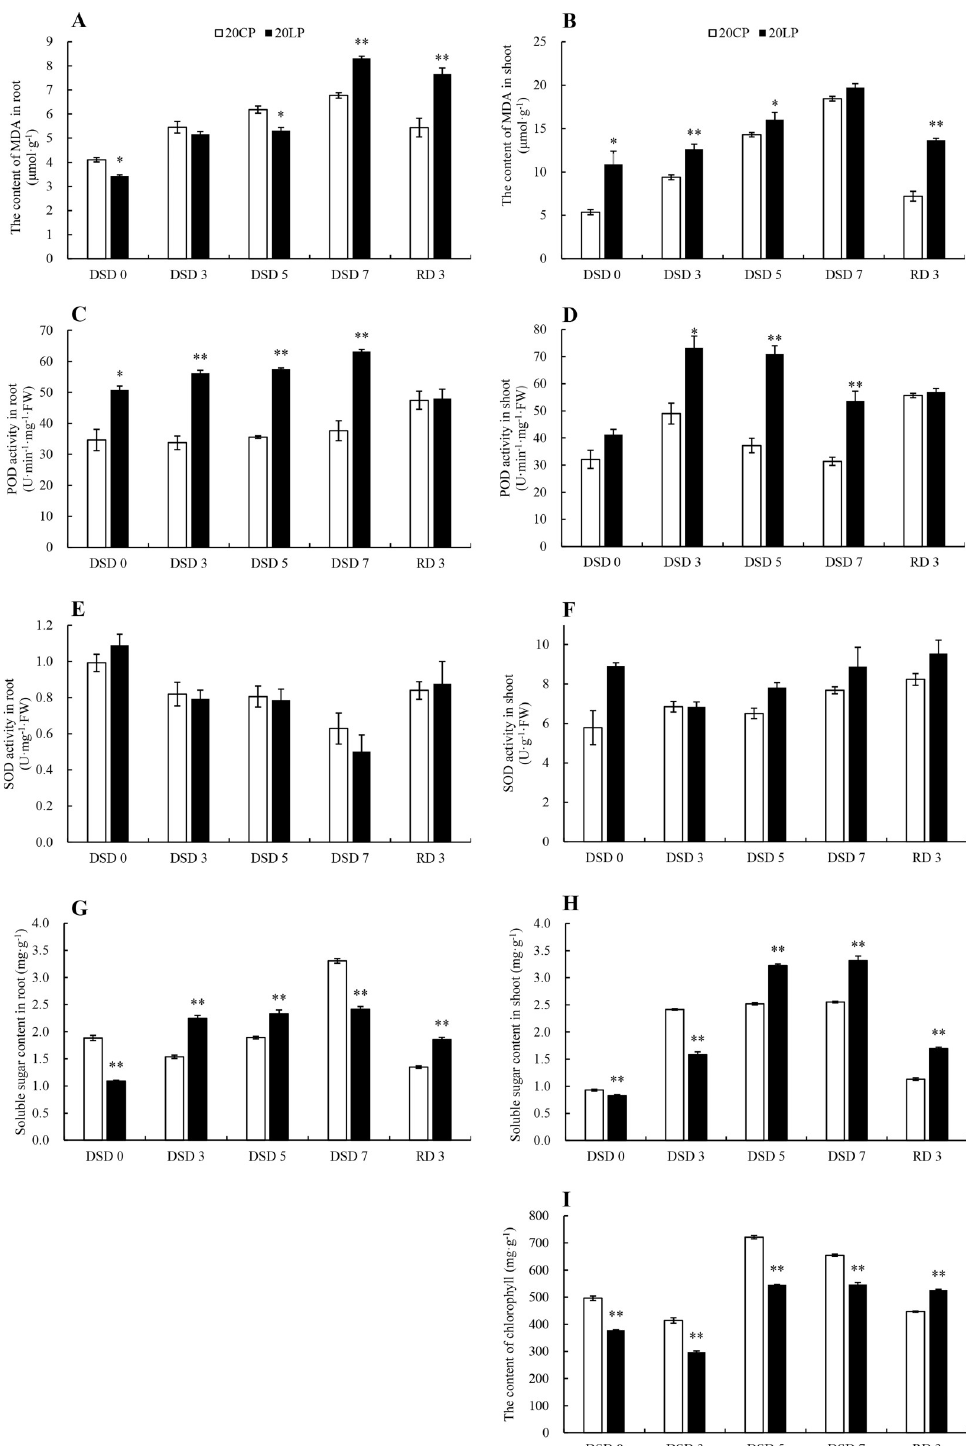
Fig 5. Physiological and biochemical indexes of wheat plants. Note: CP: conventional phosphorus; LP: low phosphorus; Values are means ± standard deviation of three repetitions; � and �� indicate significantly different at p < 0.05 and p < 0.01, respectively. 20CP: Xindong20 under conventional phosphorus level; 20LP: Xindong20 under low phosphorus level. MDA: malondialdehyde; SOD: superoxide dismutase; POD: peroxidase.